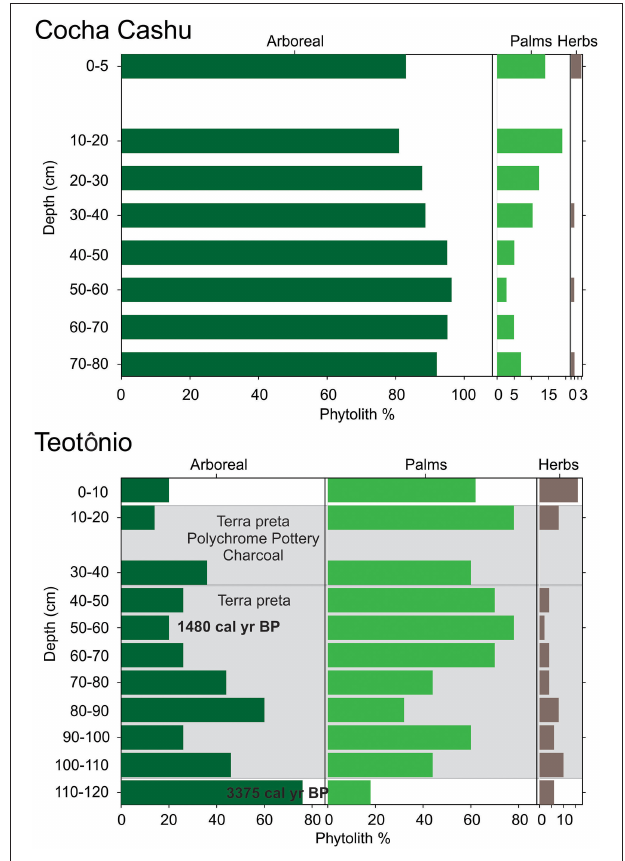
FIGURE 3 | Arboreal, palm, and herbaceous/early successional (herb) phytoliths from the Teotônio archeological site and the Cocha Cashu research station. The x-axis contains phytolith percentages, and the y-axis is core depth. 14 C AMS dates, descriptions of pottery, charcoal, and soil type are from Almeida and Neves